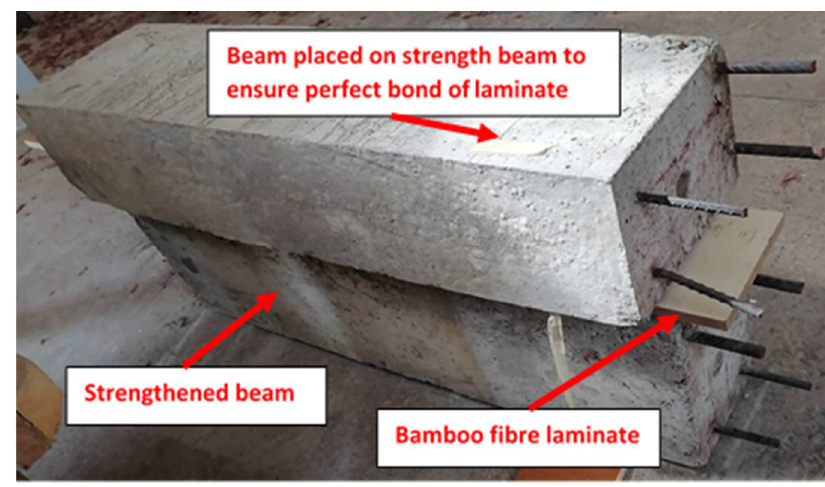
Figure 6. Bonding of bamboo laminate to the surface of the corroded beam.